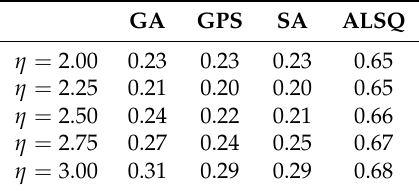
Table 1. Estimation error (meter) comparison of all algorithms with different path loss exponents.